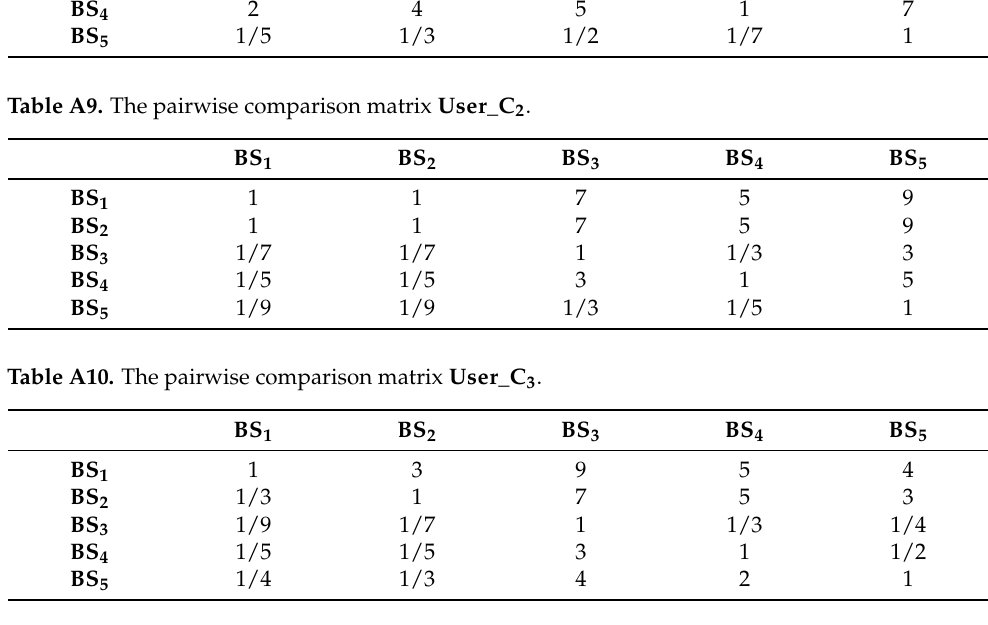
Table A11. The pairwise comparison matrix User _ C 4